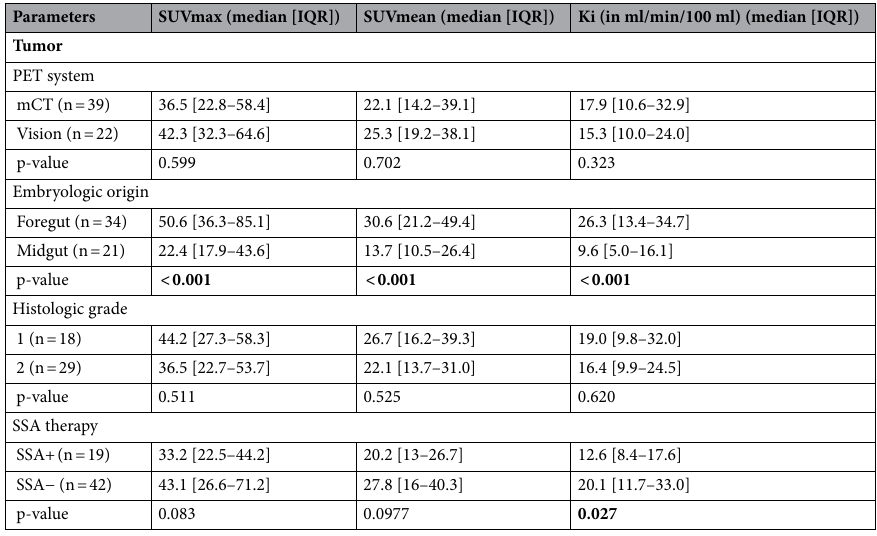
Table 4. Median values of tumoral parameters according to the cohort characteristics. Bold characters corresponded to p value